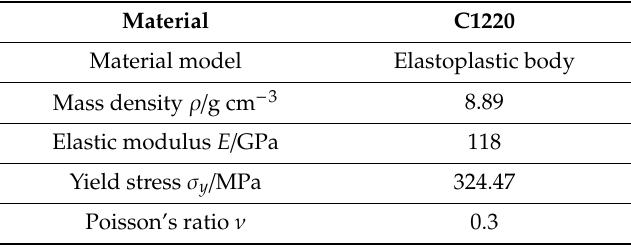
Figure 7. Schematic of finite element (FE) model for T-shape MTHF. Table 1. Mechanical properties of C1220 copper microtube used in the finite element method (FEM).